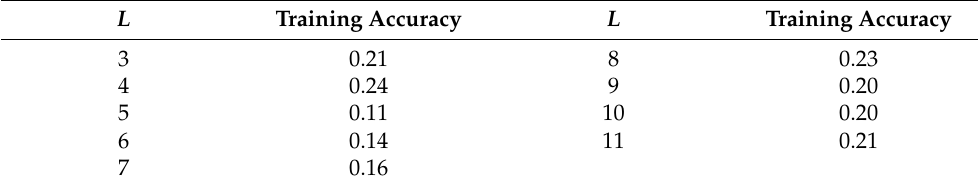
Table 4. Training accuracy under different numbers of hidden layer